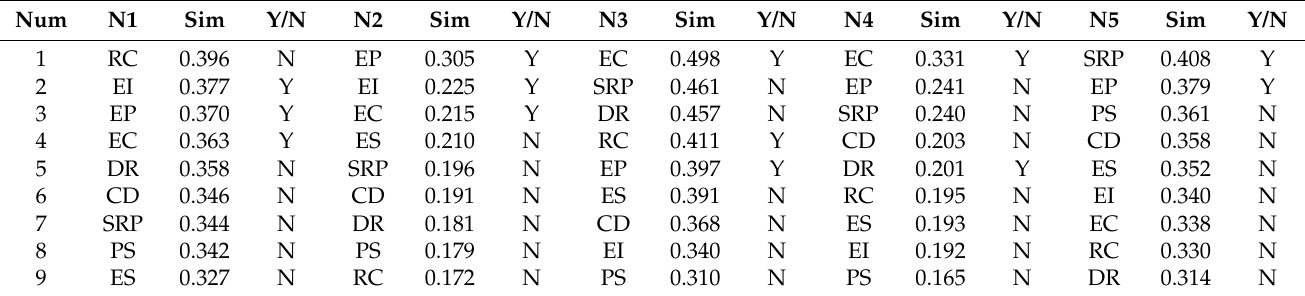
Table 9. N1–N5 Test event target domain subject division prediction results.